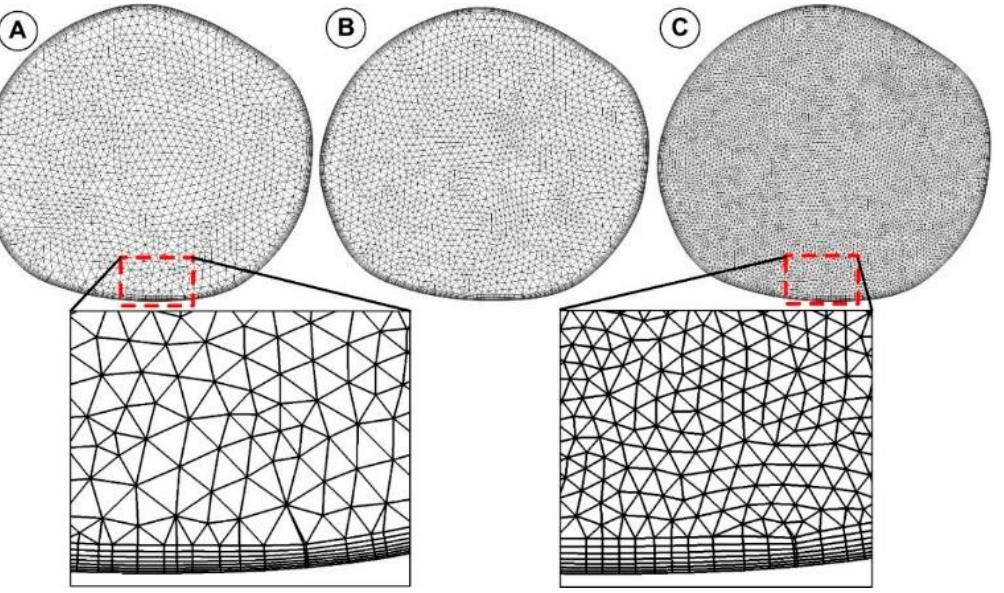
Figure 5. Cros-sectional view of the mesh topology and the generated boundary layer. The figure shows the mesh generated for the inlet section. ( A ) coarse mesh (4582 cells); ( B ) medium mesh (6386 cells); and ( C ) fine mesh (13,782 cells).